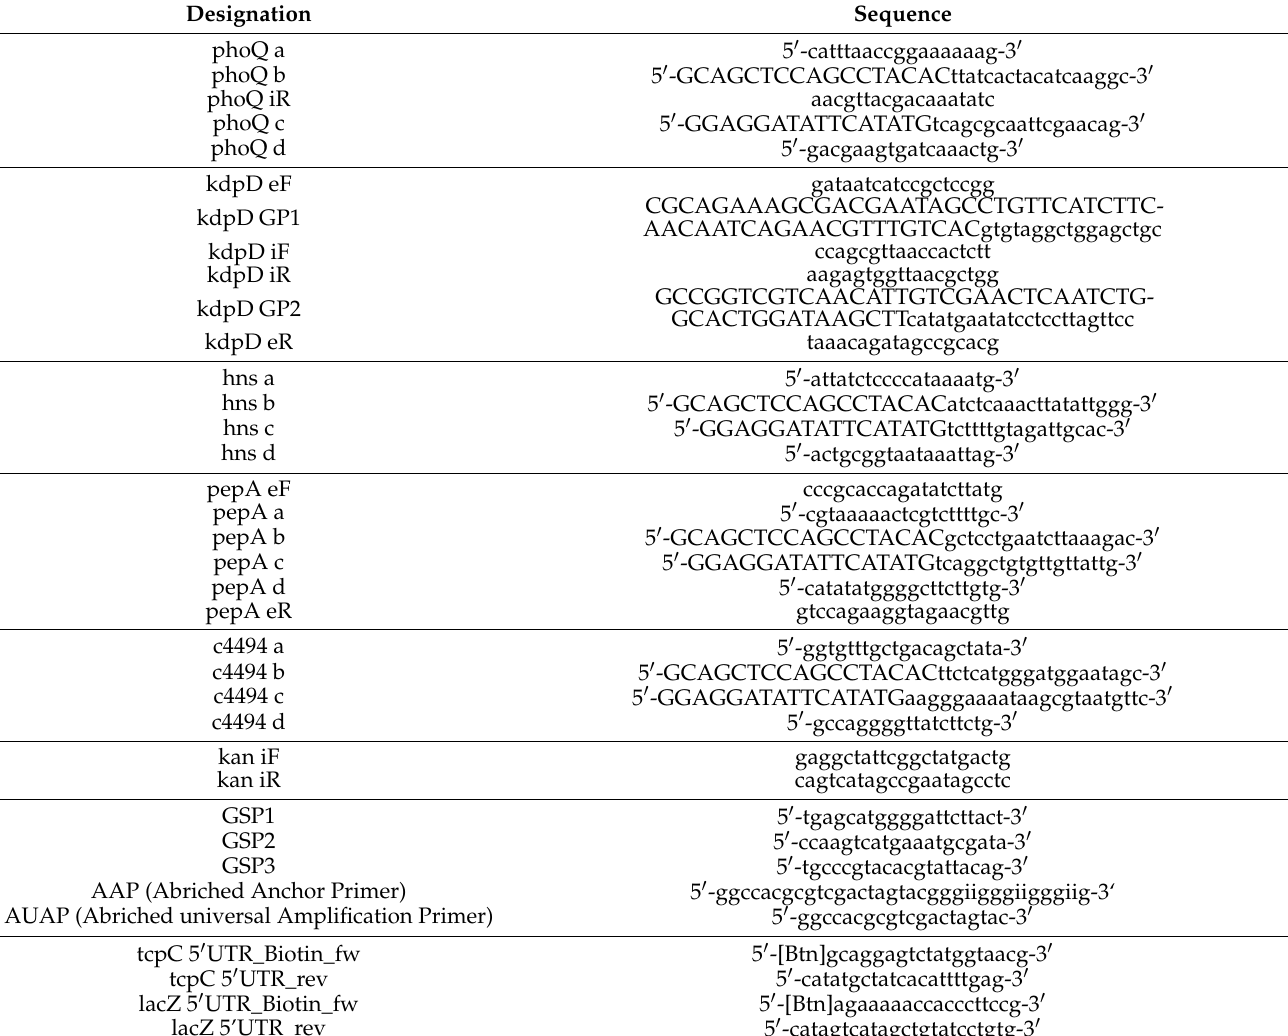
Table 3. Primer names and sequences. Upper case letters represent overhangs.